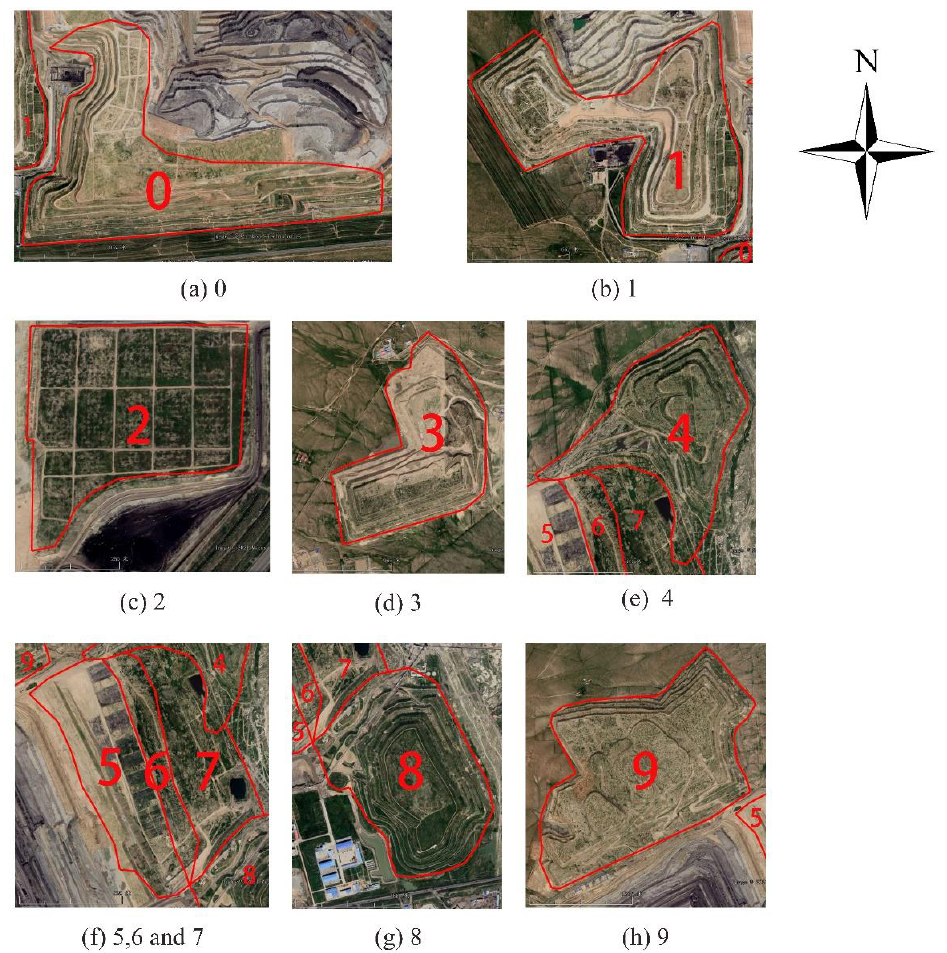
Figure 10. Google Earth high-resolution remote sensing image of each vegetation restoration area (true color, imaging time August 22, 2020). ( a ) Google Earth image in area 0 ( b ) Google Earth image in area 1 ( c ) Google Earth image in area 2 ( d ) Google Earth image in area 3 ( e ) Google Earth image in area 4 ( f ) Google Earth image in area 5,6 and 7 ( g ) Google Earth image in area 8 ( h ) Google Earth image in area